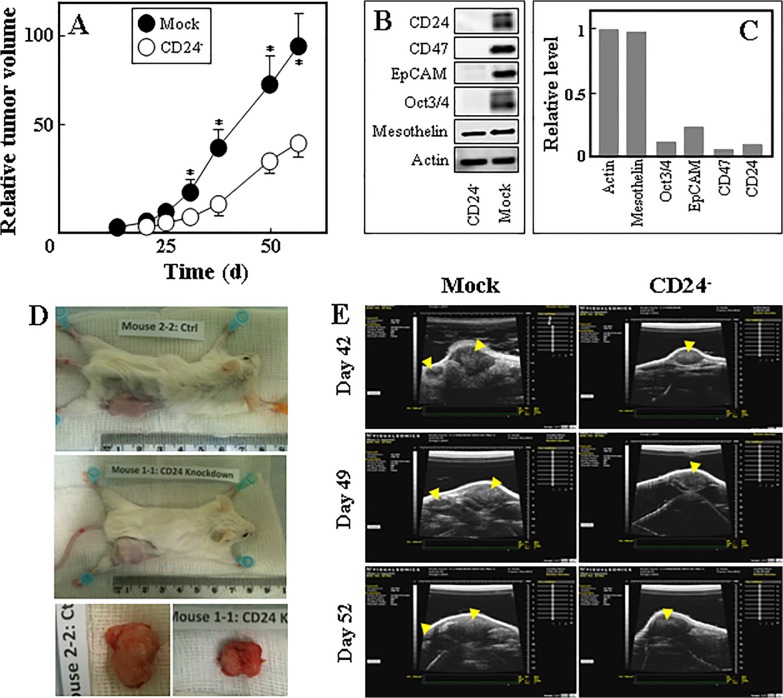
CD24 supports initiation and progression of mesotheliomas.(A) Mock-transfected and CD24- Ist-Mes-2 cells (106 per animal) were grafted subcutaneously into NOD/SCID mice and tumour formation followed using USI. (B) CD24- and mock-transfected Ist-Mes-2 cell-derived tumours were evaluated for CD24, CD47, EpCAM and Oct3/4 by western blotting using anti-actin IgG as a loading control, with panel C documenting densitometric evaluation of the blots. (D) A representative image of a mouse with CD24- cell-derived tumour and parental cell-derived tumour is shown. (E) Representative USI images of a tumour derived from mock-transfected and CD24- cells acquired on different days are shown, with the yellow arrows indicating the position of the tumours. Data in panel A are mean values ±S.E.M., and are derived from four animals. The symbol ‘*’ denotes statistically significant differences with p<0.05. Images in panel B are representative of two independent experiments with the densitometric evaluation showing average data with differences less than 10%.